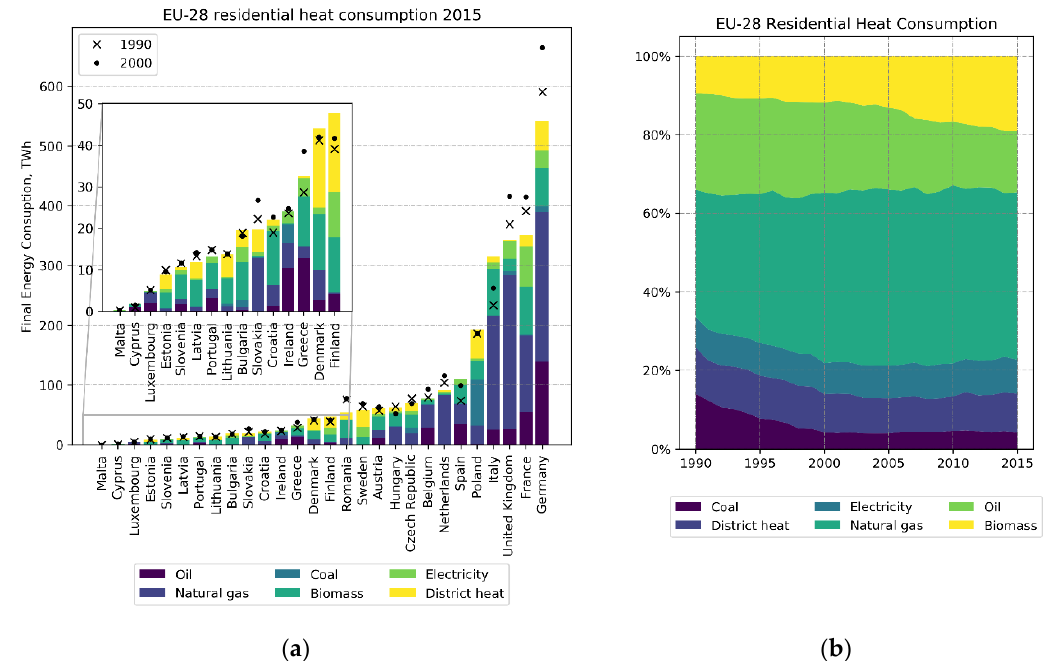
Figure 5. ( a ) Final energy consumption for residential heat consumption in the EU-28 in 2015. MSs with residential heat consumption lower than 50 TWh are enlarged in the inset. The residential heat consumption from 1990 and 2000 is included to show the development of final energy consumption for residential heating. ( b ) Development of final energy consumption share for residential heating in the EU-28 from 1990–2015.